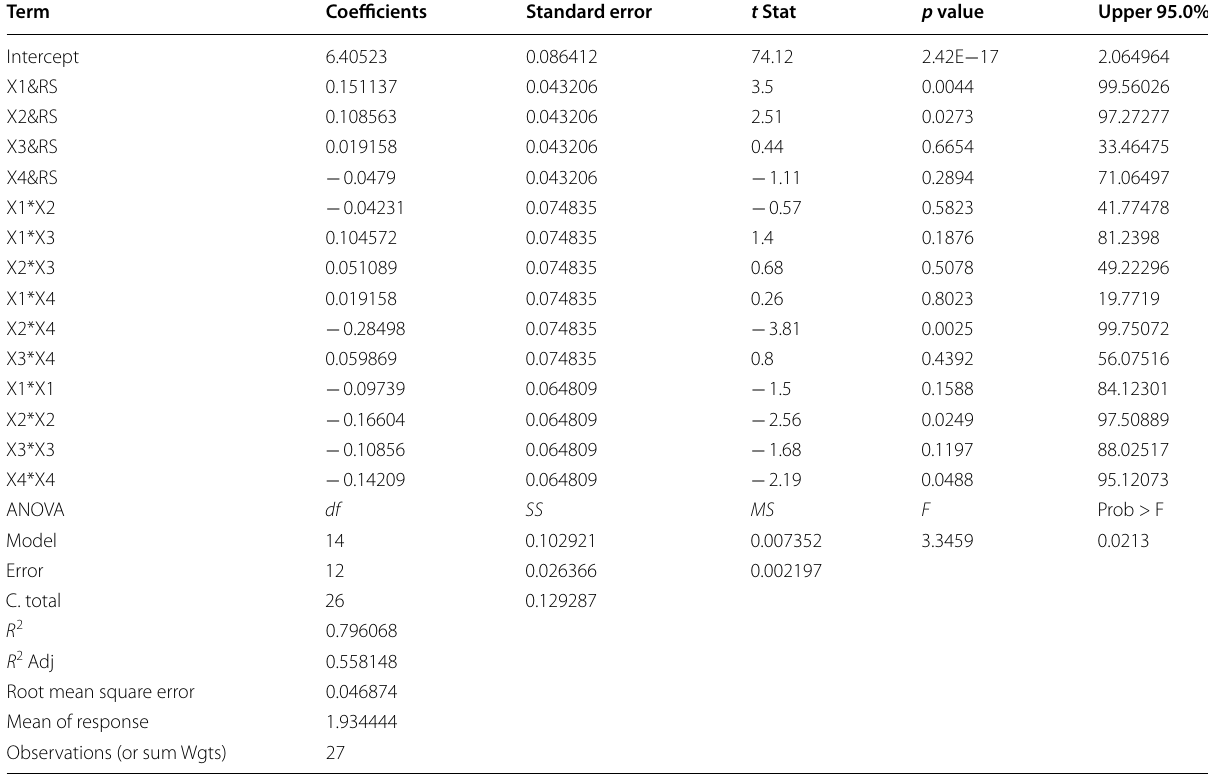
Table 4 Statistical analysis of BB design showing coefficients and t and p values for significant variables affecting the CHO by Streptomyces sp. strain